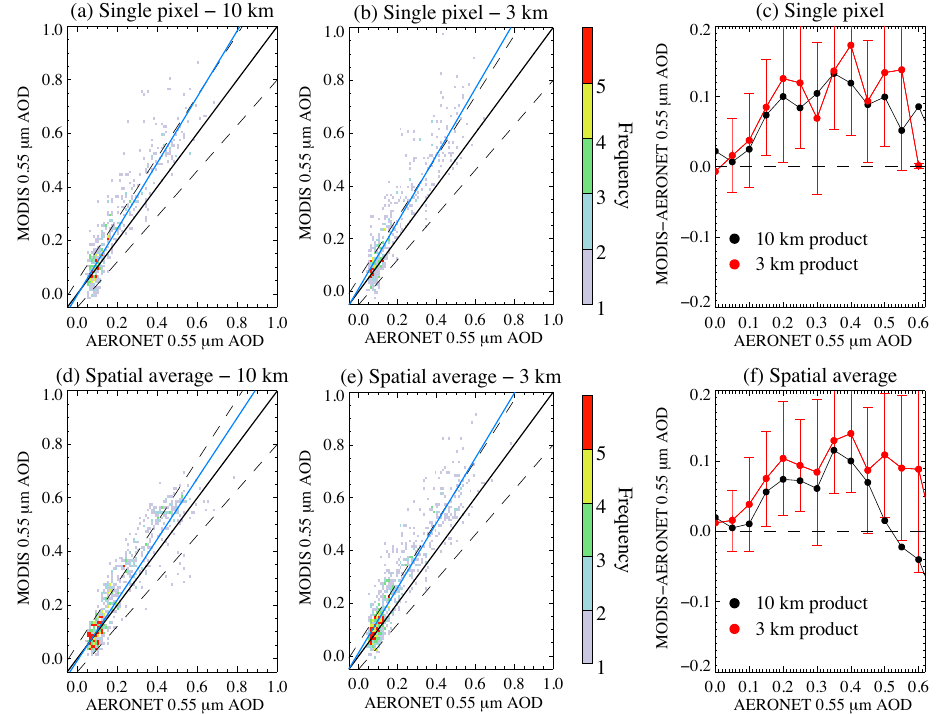
Fig. 6. (a) Density scatter plot of MODIS/SP collocations for 10km AOD at 0.55µm, using the single pixel collocation technique. Expected error over land ( ± 0.05 ± 0.15AOD) is shown in the dashed lines, the best fit line is shown by the solid blue line, and the one-to-one line is shown in the solid black line. (b) Same as in (a) , except for the 3km product. (c) Average difference between MODIS single pixel collocations and SP 0.55µm AOD, as a function of SP 0.55µmAOD. A standard deviation of ± 1 is shown for the 3km product. (d–f) As in (a–c) , except the MODIS 5 × 5 pixel spatial average collocation is